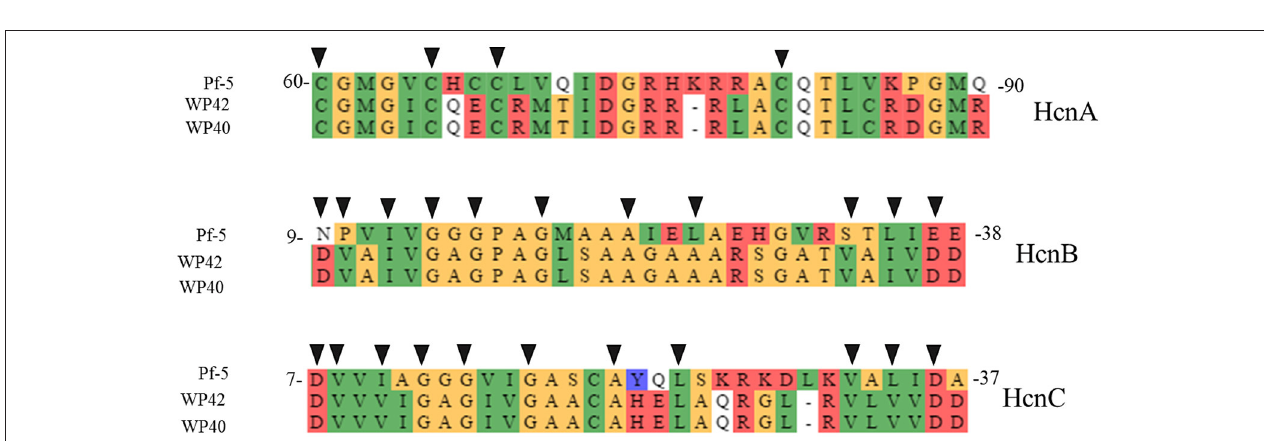
FIGURE 3 | Protein alignment of putative hcn biosynthetic genes in WP40 (Locus tag: Ga0008008_101290–101292), and WP42 (Locus Tag: EX20DRAFT_00138–00140) with HcnA, B, and C from P. fluorescens Pf-5. The conserved amino acid residues of Fe-S binding sites, in HcnA, and ADP-binding motif, in HcnB and HcnC, important for hydrogen cyanide synthases function (Laville et al., 1998; Ryall et al., 2008), are indicated with black triangles.